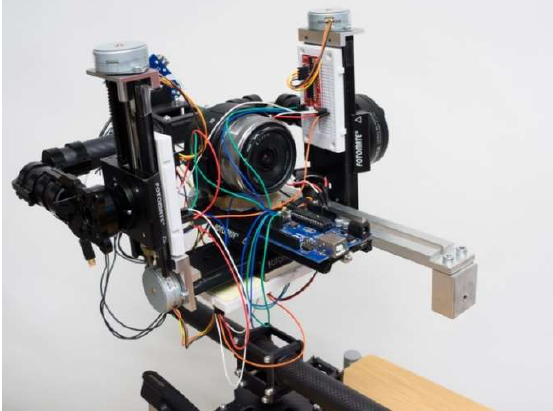
Figure 7: A low-cost frame camera on a motorized mount